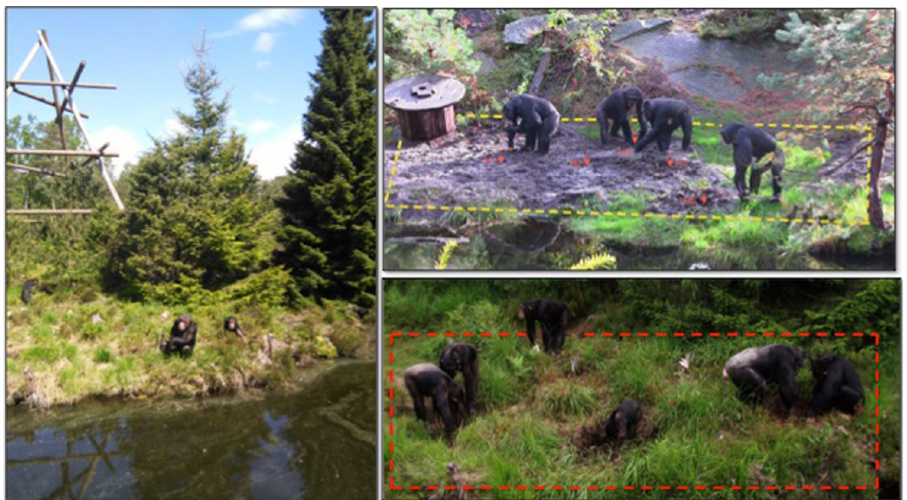
Fig 1. The outdoor enclosure or island. The yellow and red rectangles indicate the study areas during Experiments 1 and 2 respectively. The left picture illustrates the natural vegetation present in the island consisting of trees, shrubs, herbs and